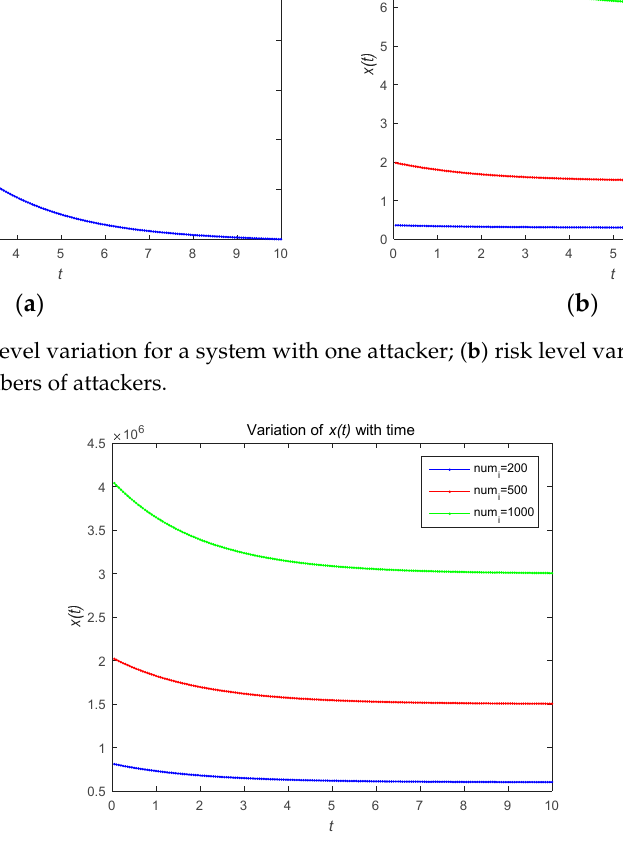
Figure 4. Risk level with a large number of attackers under open-loop control.